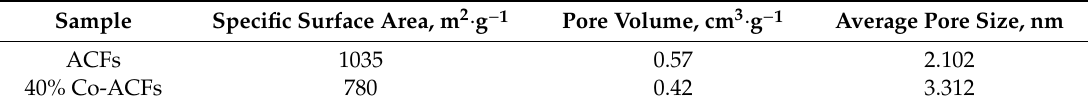
Figure 2. N 2 adsorption − desorption isotherms ( a ) ACFs and ( b ) 40% Co-ACFs, red line: adsorption curve, black line: desorption curve; pore size distributions ( c ) ACFs and ( d ) 40% Co-ACFs. Table 1. Physical properties of Co loading catalysts.